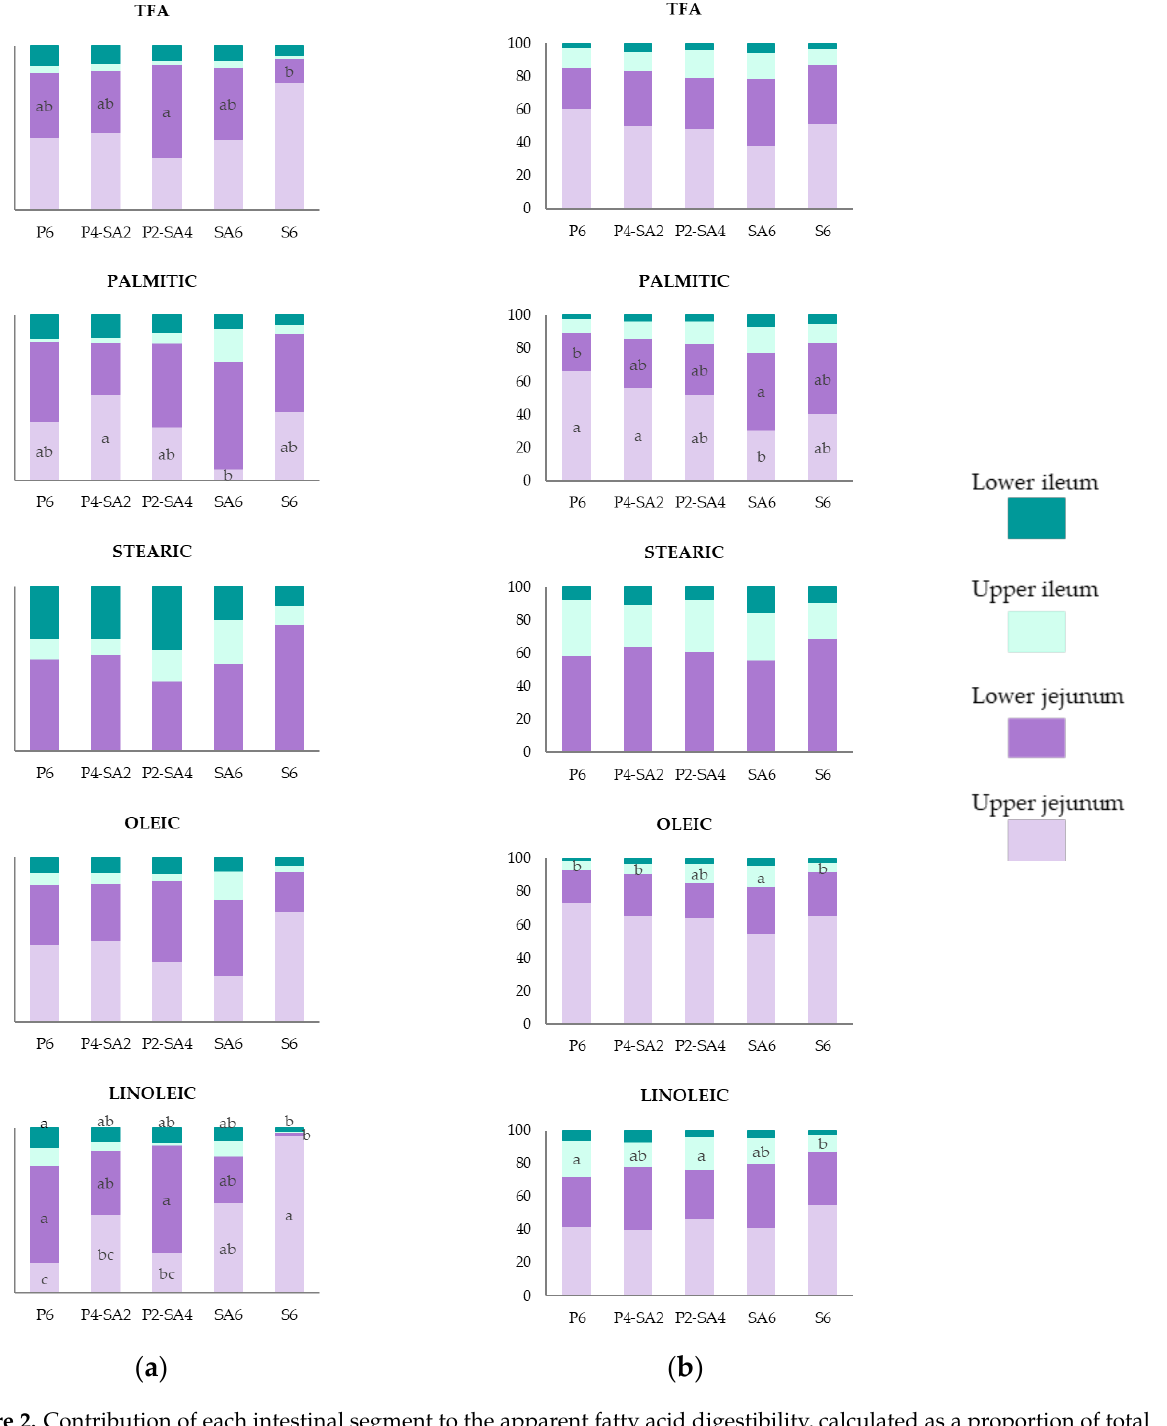
Figure 2. Contribution of each intestinal segment to the apparent fatty acid digestibility, calculated as a proportion of total digestibility reached at the lower ileum, along the intestinal tract for the five different diets; with 6% of palm oil (P6), blend with 4% palm oil + 2% soybean acid oil (P4-SA2), blend with 2% palm oil + 4% soybean acid oil (P2-SA4), with 6% of soybean acid oil (SA6) and with 6% soybean oil (S6) in ( a ) 11-d-old broiler chickens and ( b ) 35-d-old broiler chickens. TFA (total fatty acids), PALMITIC (C16:0), STEARIC (C18:0), OLEIC (C18:1 n-9) and LINOLEIC (C18:2 n-6) acids. Values are means of 6 replicates per each diet with 12 chickens/replicate at 11 d, and 2 chickens/replicate at 35 d. a–c : within the same intestinal segment, columns not sharing a common letter are significantly different ( p < 0.01).